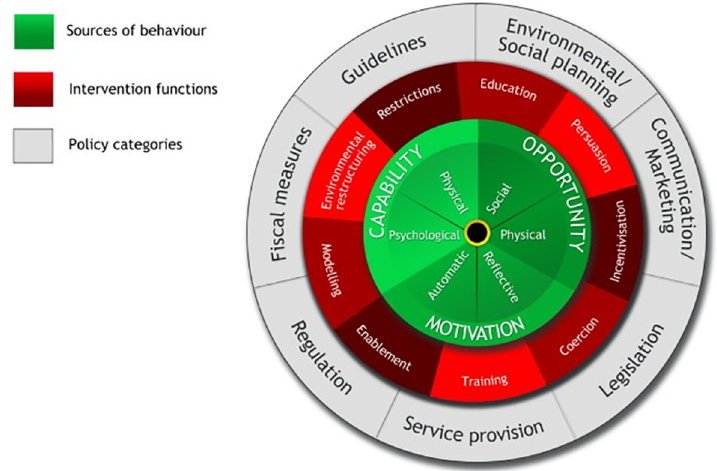
Fig 1. The behaviour change wheel. Reprinted from “The behaviour change wheel: A new method for characterising and designing behaviour change interventions,” by S. Michie, M. M. van Stralen and R. West, 2011, Implementation Science, 6(42), p. 7. Copyright [2011] by Michie et al., licensee BioMed Central Ltd. Used under Creative Commons Attribution License: http://creativecommons.org/licenses/by/2.0.